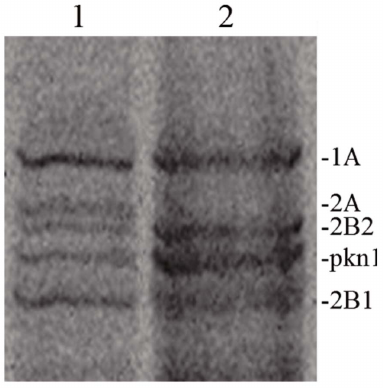
Figure 3. Effect of tannic acid on PBPs from L.plantarum WCFS1 . PBPs were extracted from L. plantarum WCFS1 cells grown in absence (1) or in presence (2) of 0.5 mM tannic acid and labelled with Bocillin FL. These proteins were separated by SDS-PAGE and detected on the